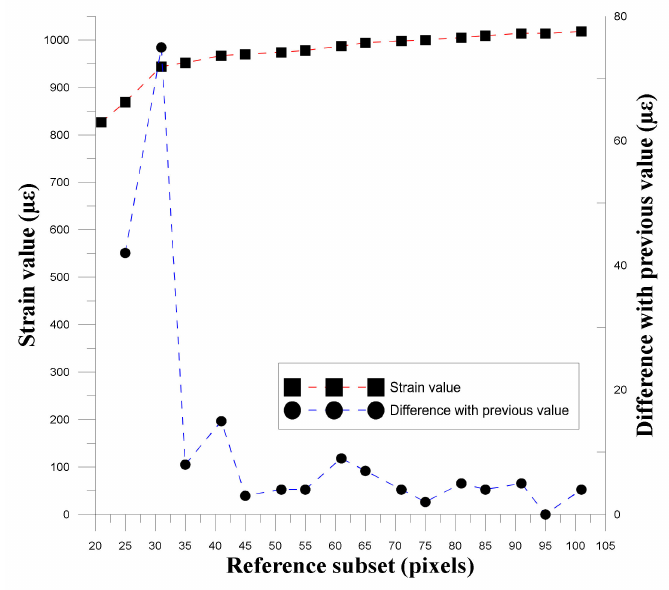
Figure 6. Trend graph of strain variation and strain difference in the second group as the size of the reference subset changes.